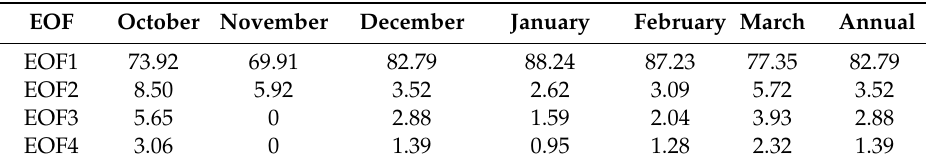
Table 1. The explanatory weights of the major empirical orthogonal functions (EOFs) for monthly and annual snow depths in % (means proportion of total variance that can be explained by the corresponding EOF).